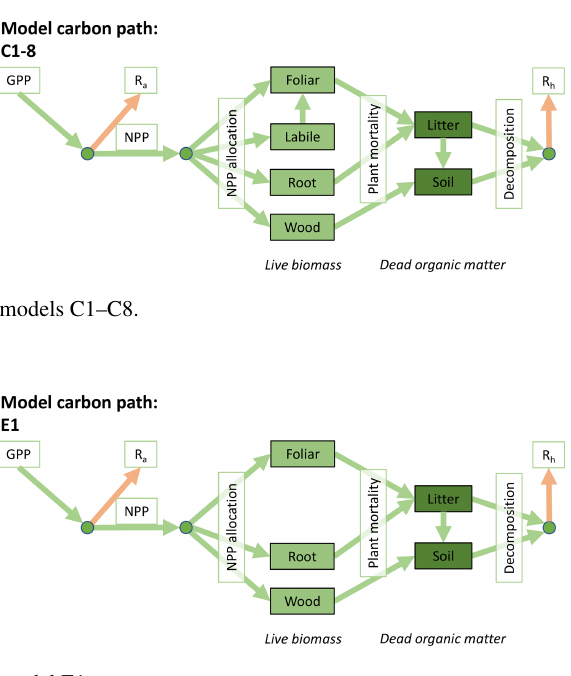
Figure B2. Carbon cycle structure for model E1.